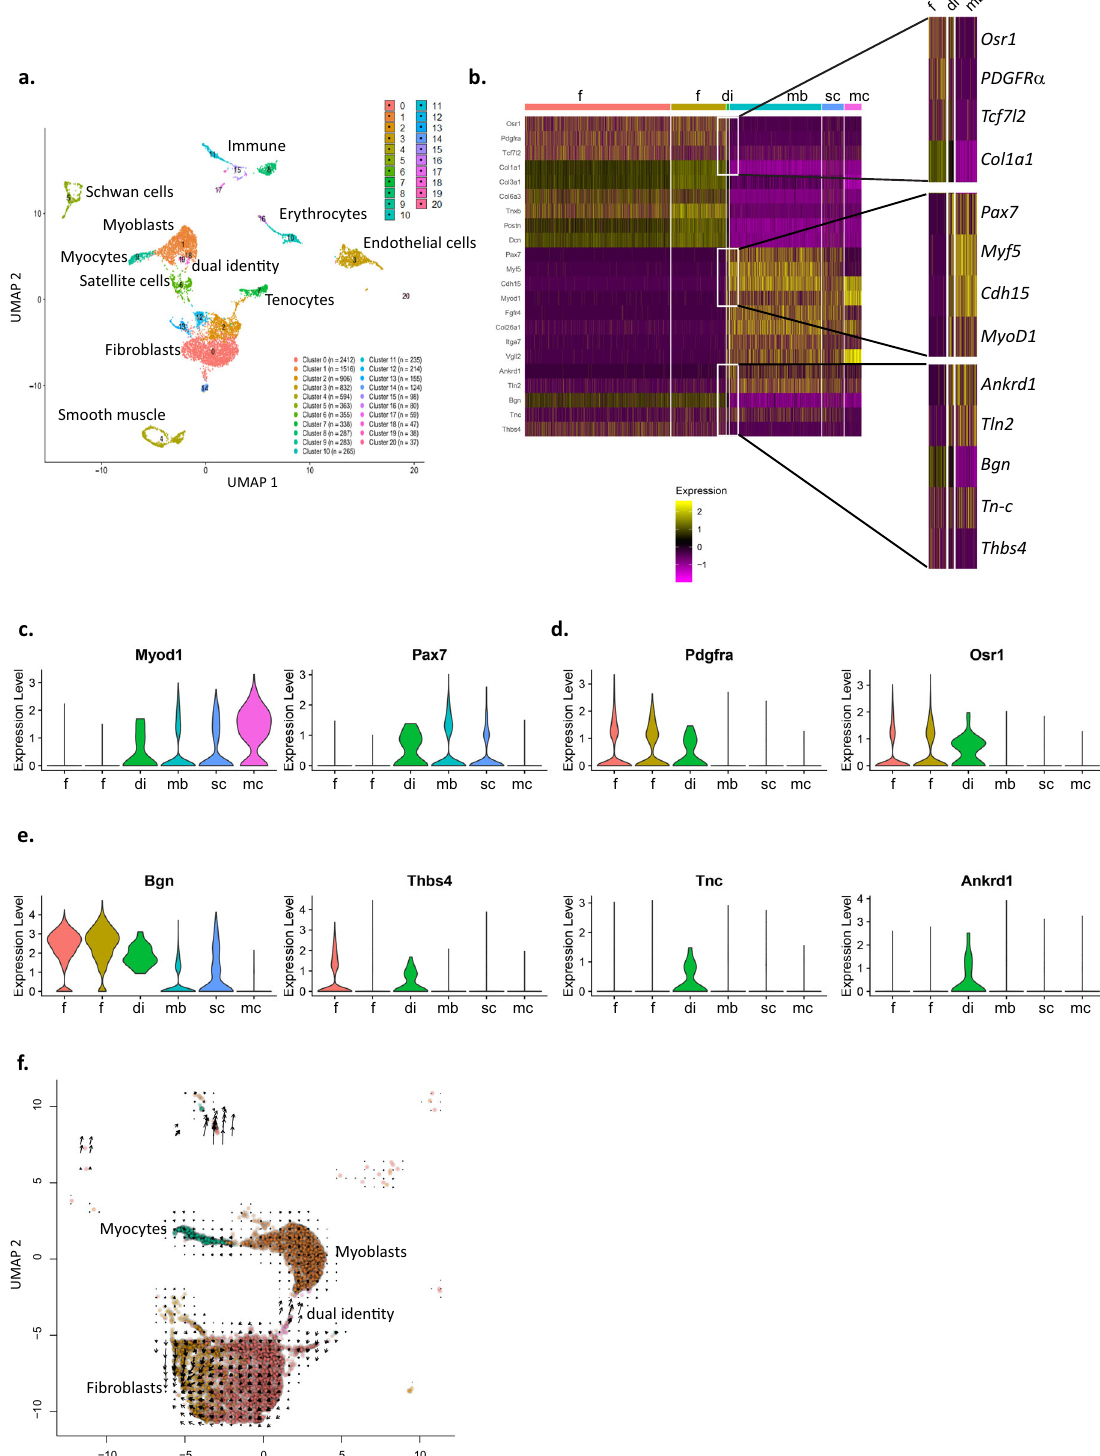
Fig. 1 scRNA sequencing reveals cells with dual myogenic and interstitial transcriptional identities. UMAP depicting cell clusters ( a ) heat map ( b ) and violin plots of distinct genes associated with myogenesis ( c ) FAPs/ fi broblasts ( d ), and tendon and MTJs ( e ). UMAP of RNA velocity analysis of myogenic (1,6,9), fi brogenic (0,2) and dual identity clusters ( f ). f fi broblasts, mb myoblasts, mc myocytes, sc satellite cells, di dual